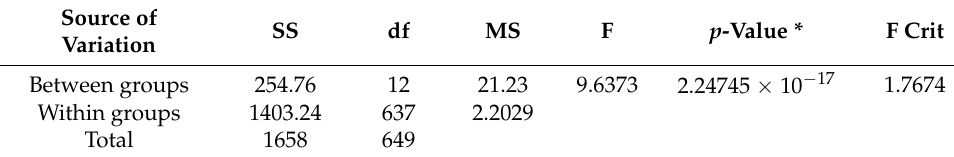
Table 9. Source of variation ANOVA.